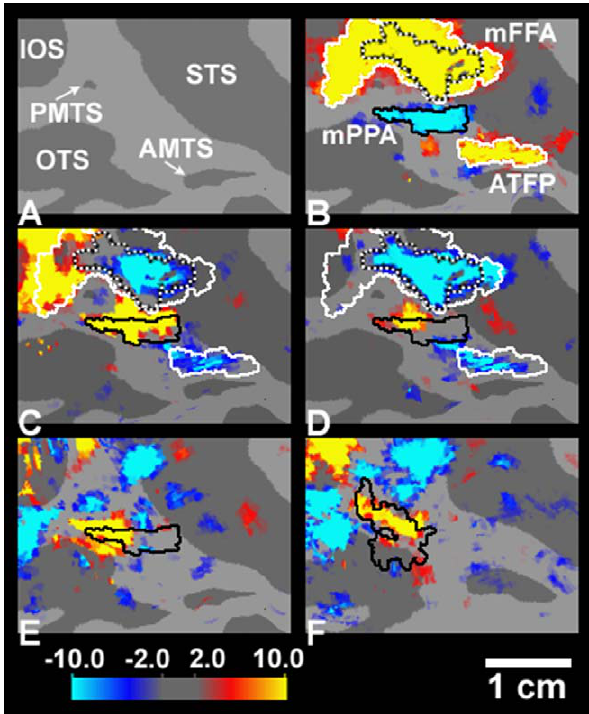
Figure 9. Topographic relationship between SF selectivity and place/face selectivity in macaque IT cortex. (A) A flattened view of macaque IT cortex (left hemisphere); posterior-to-anterior is left-to-right in this figure. Major sulci in this view are the following: AMTS, anterior middle temporal; IOS, inferior occipital; OTS, occipito-temporal; PMTS, posterior middle temporal; STS, superior temporal. (B) The activity map for normal faces (yellow) versus normal places (cyan) in the same hemisphere. As described earlier (e.g., [2,33]), we consistently found a large face patch (here termed mFFA, based on its apparent homology with human FFA) in the fundus and the lower bank of superior temporal sulcus, and a smaller ‘‘anterior temporal face patch’’ (ATFP) in the upper bank of anterior middle temporal sulcus. Our maps also revealed a robust place-selective patch, mPPA (see also Figure 8, the upper-right panel), located adjacent and anterior-ventral to the mFFA. (C and D) The activity maps for high SF (yellow) versus low SF (cyan) places (C), and high SF (yellow) versus middle SF (cyan) faces (D) in the left hemisphere. The mPPA (especially its dorsal and posterior subdivisions) responded selectively to high SFs, whereas the face- selective mFFA (especially the central ‘‘hot spot’’ area of mFFA, which is most face-selective) responded selectively to lower SFs; a similar selectivity was found in the anterior face-selective area (anterior temporal face patch). That hot spot center of mFFA (delineated with a black/white dotted contour) was selected by increasing the statistical threshold to p , 10 2 16 in the face/place map shown in (B). These SF-related activations were independent of the stimulus category (e.g., the ‘‘place’’ patch was preferentially activated even with high SF faces). (E and F) The activity maps for high SF (yellow) versus low SF (cyan) checkerboards in the left (E) and right (F) hemispheres. Again the mPPA in both hemispheres (marked with a black contour) showed a selective activation to high SFs.